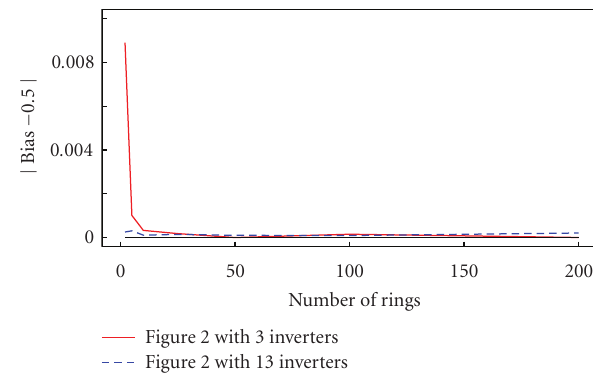
Figure 1 with 3 inverters Figure 1 with 13 inverters Figure 2 with 3 inverters Figure 2 with 13 Figure 4: Bias of the TRNG on Figures 1 and 2.